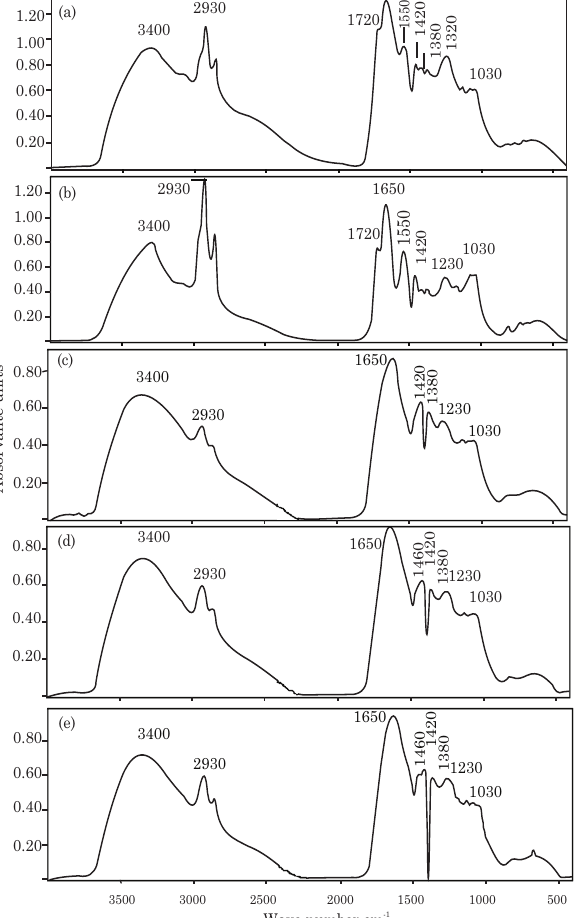
S: inorganic fertilizer-soil; SL: sewage sludge-soil (18 t ha -1 ); SH: sewage sludge-soil (36 t ha -1 ). Means followed by the same letter in the column were not significantly different (ANOVA and Tukey test, p < 0.05)